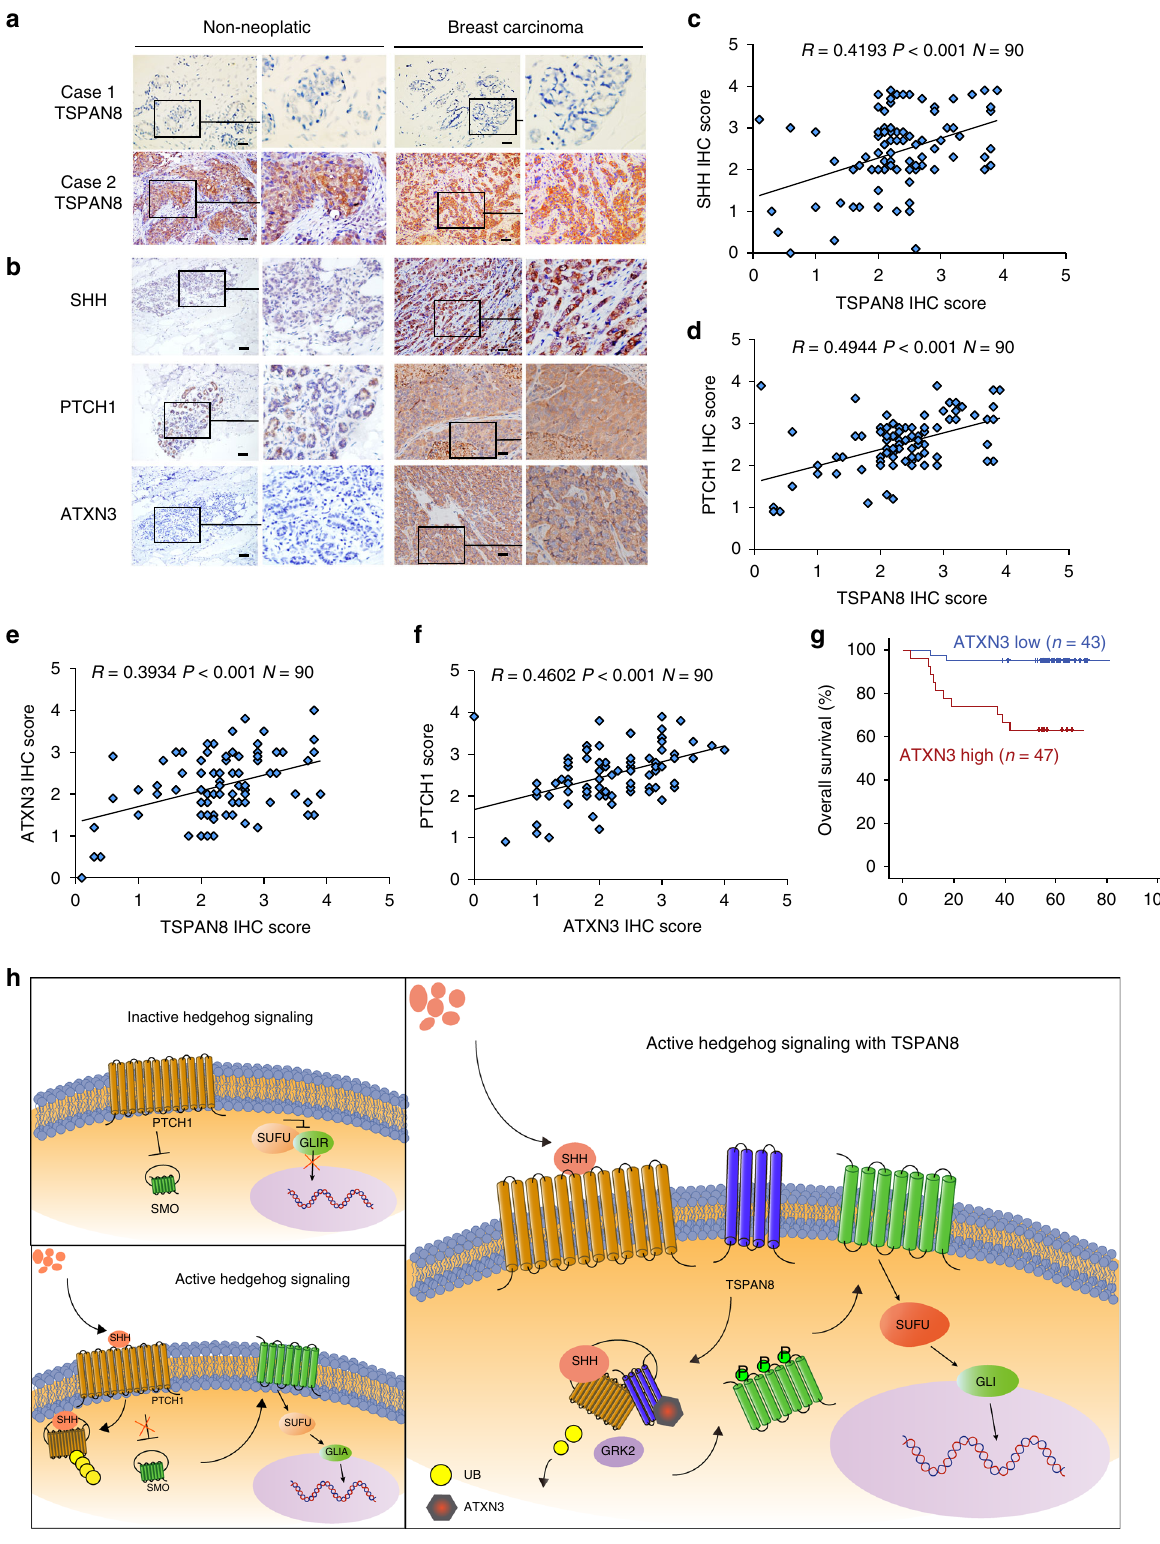
Cell growth assay . Cells were seeded on 24-well plates in 1% FBS DMEM (5000 cells per well, three parallel wells). Then, the cells were harvested after the trans- fection at different time points, and their number on each plate was counted. CCK- 8 was employed to identify dead cells when counting. Colony formation assay . Cells were suspended in 0.3% agarose (Sigma-Aldrich) and placed at a density of 50 cells per well. After 3 weeks of cultivation, the